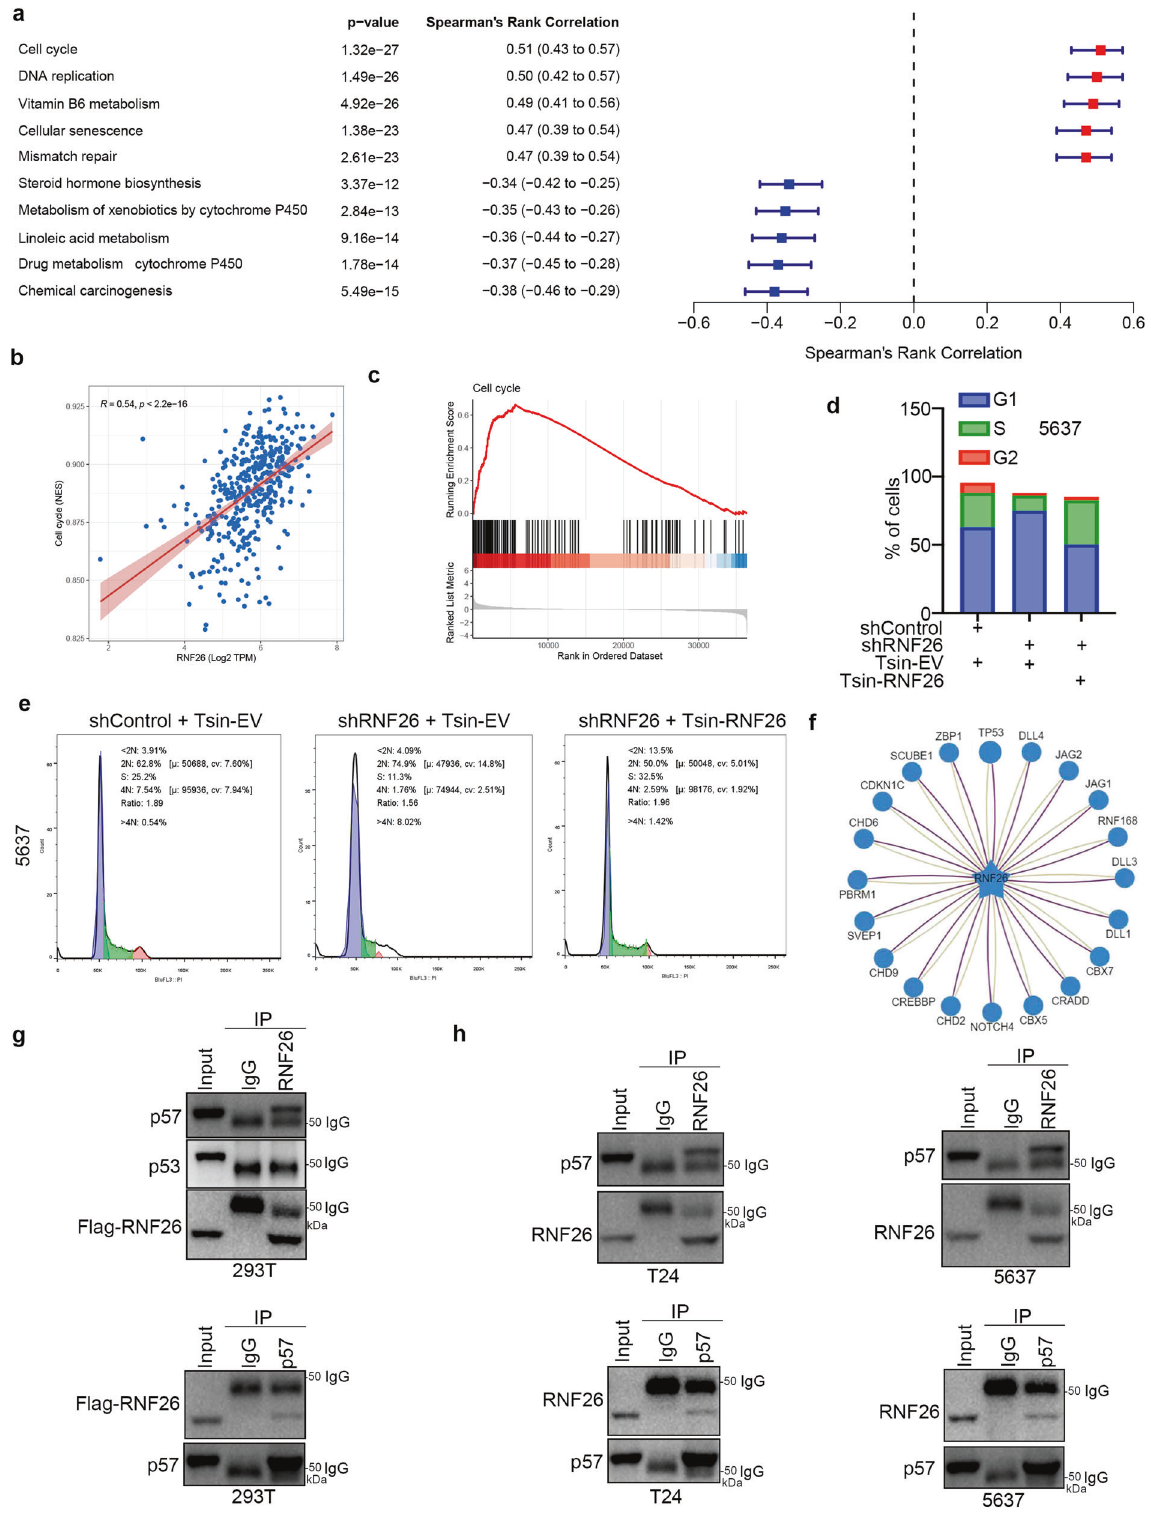
Fig. 4 RNF26 regulates the cell cycle and interacts with p57 in bladder cancer cells. a Single-sample GSEA (ssGSEA) showed the top fi ve pathways positively correlated with RNF26 and the top 5 pathways negatively correlated with RNF26 in TCGA-BLCA dataset. b Correlation analysis between RNF26 and cell cycle pathway in TCGA-BLCA dataset. c Cell cycle pathway was activated by the overexpression of RNF26 in TCGA-BLCA dataset. d , e 5637 cells were infected with indicated constructs for 72 h. After puromycin selection, cells were subjected to cell cycle analysis. f UbiBrowser showed the top 20 substrate proteins that might interact with RNF26. g 293T cells were transfected with Flag- RNF26 for 24 h. Cells were harvested and underwent co-IP assay by using the RNF26 or p57 antibodies, respectively. h T24 and 5637 were harvested and underwent co-IP assay by using the RNF26 or p57 antibodies respectively.